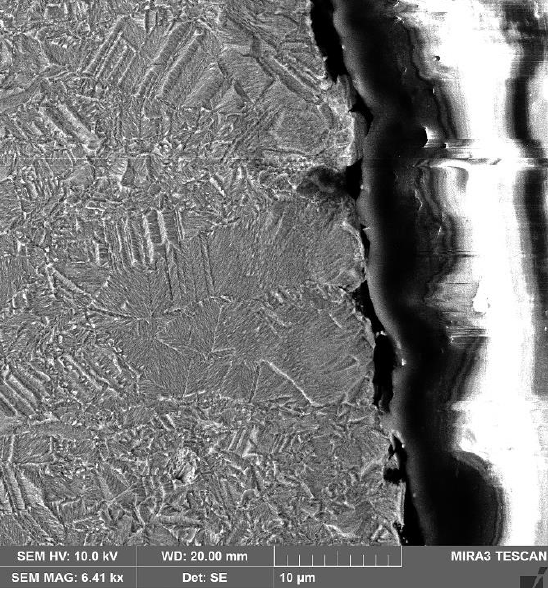
Figure 3. Micrograph of the SS-19 cathode cross-section. No nodulation has occurred, but 5 µm ridges are visible and may act as adhesion sites for anode slime.